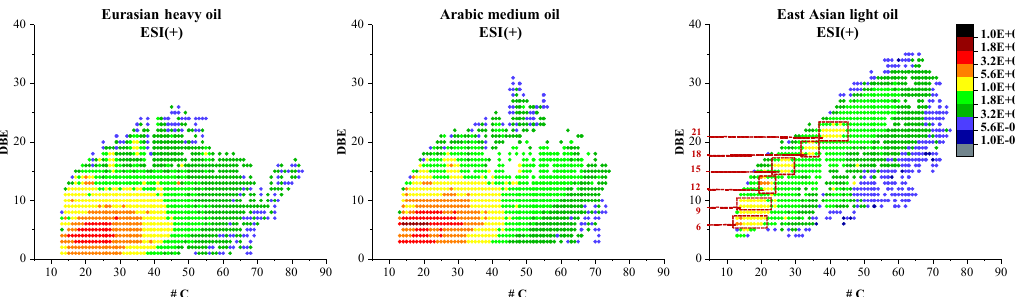
Figure 5. Kendrick plots of the S[H] class for ESI( + ) measurements of saturates from Eurasian heavy oil ( left ) Arabic medium oil ( middle ) and E. Asian light oil ( right ). Color-coding represents the intensity of the corresponding monoisotopic signal.